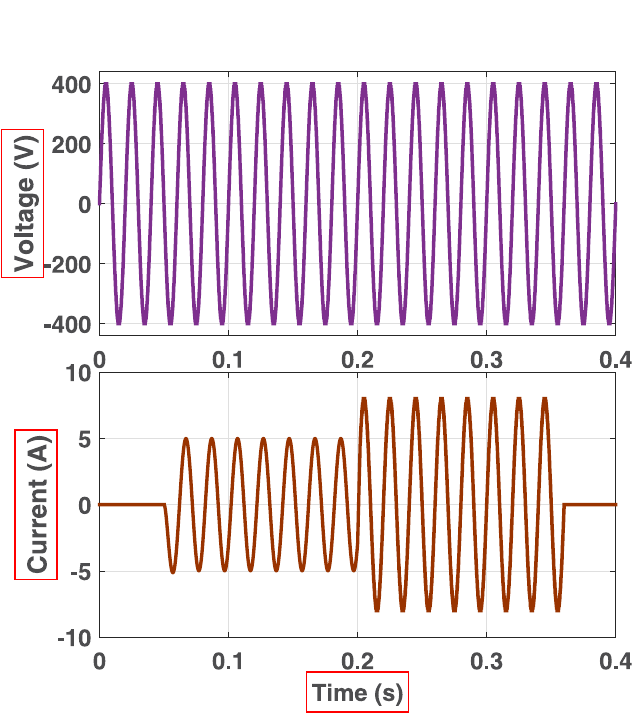
Fig 19. Effect of dynamic load switching on 81-level MWMLI: No-load ! 1 kVA @0.8 PF lagging ! 1.6 kW ! no-load.